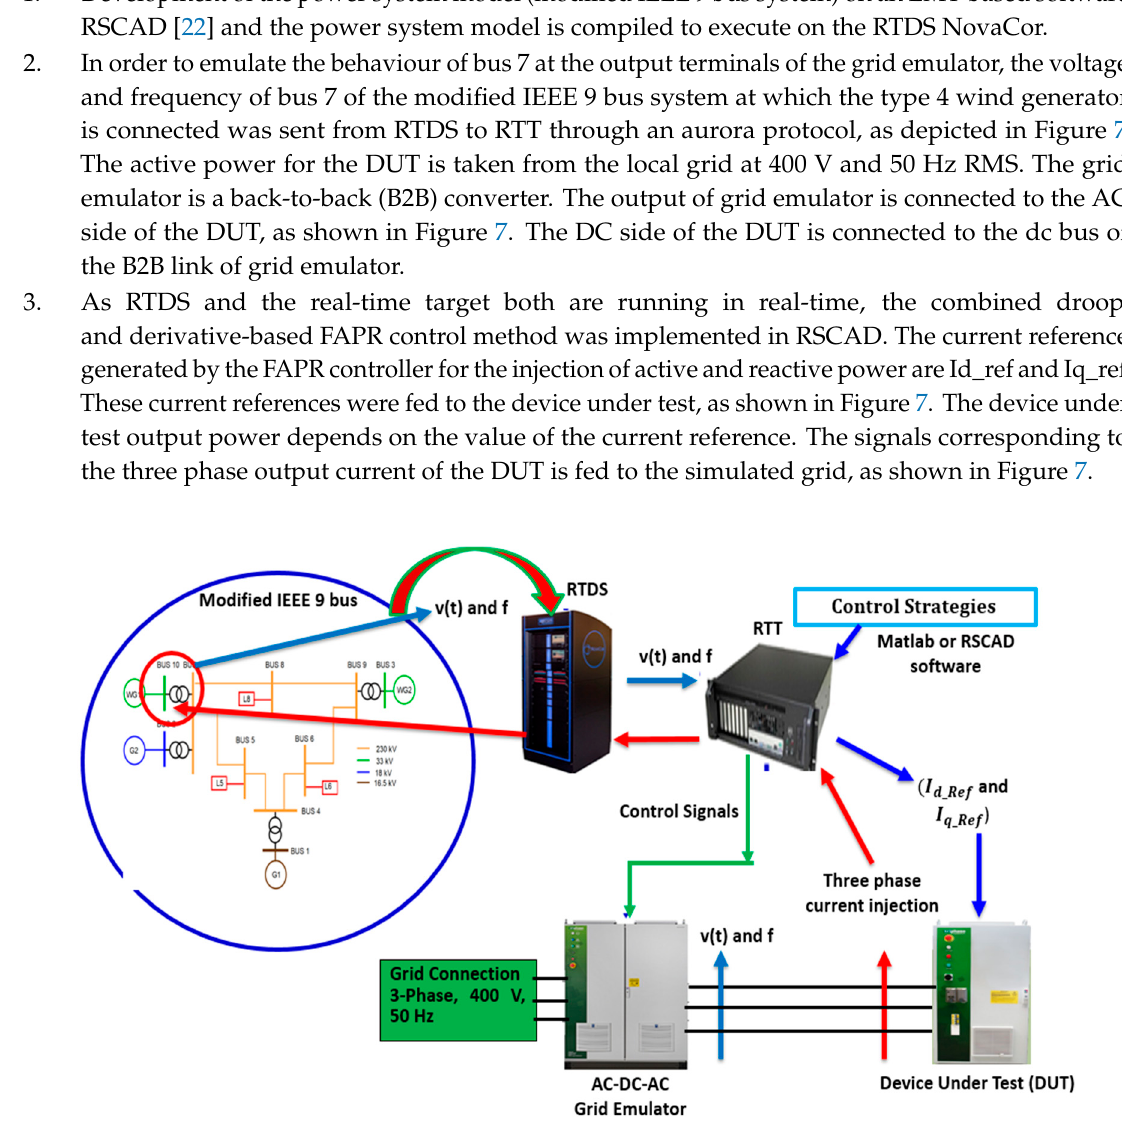
Figure 7. Illustration of FAPR control testing through PHIL.